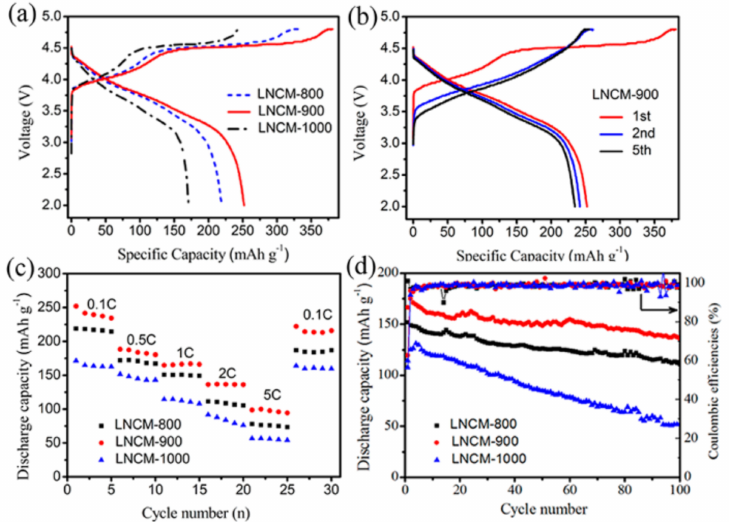
Figure 3. ( a ) Initial charge and discharge curves of LNCM-800, LNCM-900, and LNCM-1000 at 0.1C in the potential range from 2.0 to 4.8 V, ( b ) Charge-discharge curves of LNCM-900 at 0.1C, ( c ) The rate capability, ( d ) Cycle performance of all samples at 1